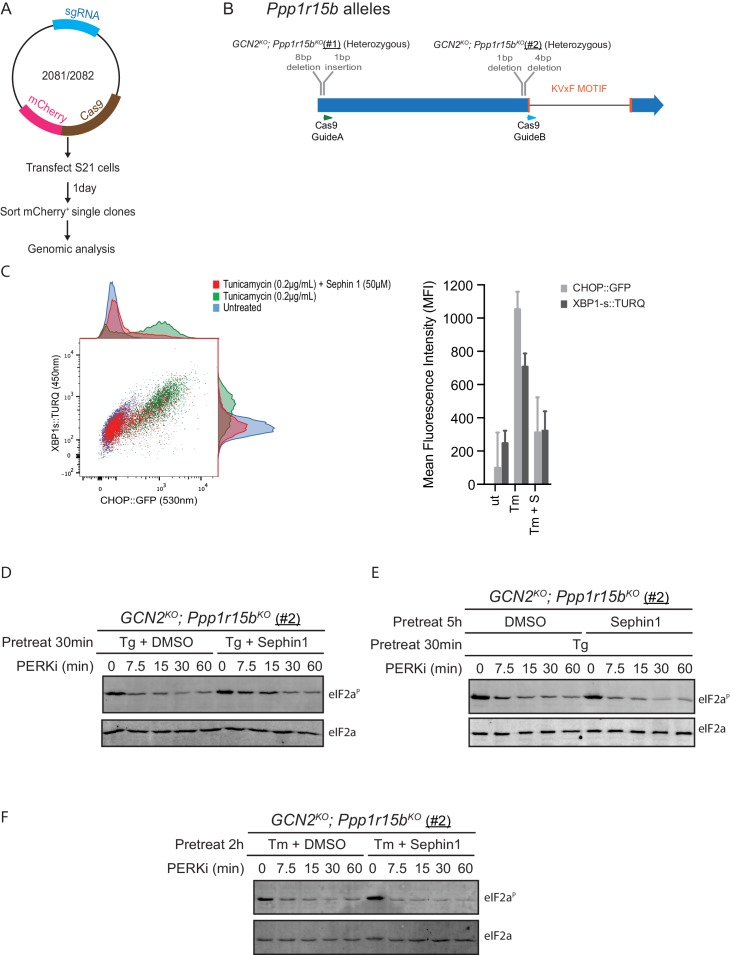
Analysis of Sephin1 in a different Ppp1r15b mutant cell line.(A) Schema of the procedure to create dual reporter (CHOP::GFP, XBP1s::Turquoise) compound mutant Gcn2KO;Ppp1r15bKO CHO-K1 cells using the CRISPR-Cas9 system. (B) Schema of the mutant alleles. The two coding exons of wildtype hamster Ppp1r15b are denoted as is the region encoding the PP1-binding RVxF motif (KVTF, in PPP1R15B) and the positions of the guide RNAs used to direct the Cas9-mediated double strand breaks. (C) Two-dimensional plot and histograms of the fluorescent signal of the CHOP::GFP and XBP1s::Turquoise reporters in compound Ppp1r15bKO; Gcn2KO CHO-K1 cells (clone #2). Where indicated, the cells were exposed to a low concentration of tunicamycin (0.2 µg/mL; 20 hr) alone or together with Sephin1 (50 µM). The mean ± CV (coefficient of variation) of the fluorescence intensity of the two reporters is displayed in the bar diagram. Shown is one of three independent experiments. (D) As in ‘Figure 10B' but using Ppp1r15bKO; Gcn2KO (clone #2). (E) As in ‘D’ above, but Sephin1 pretreatment was extended to 5 hr, before the kinase shut-off procedure, and continued throughout. (F) As in ‘D’ above, but substituting tunicamycin (2.5 µg/mL; 2 hr) for thapsigargin as the PERK inducer. Shown is a representative experiment (of two repeats).